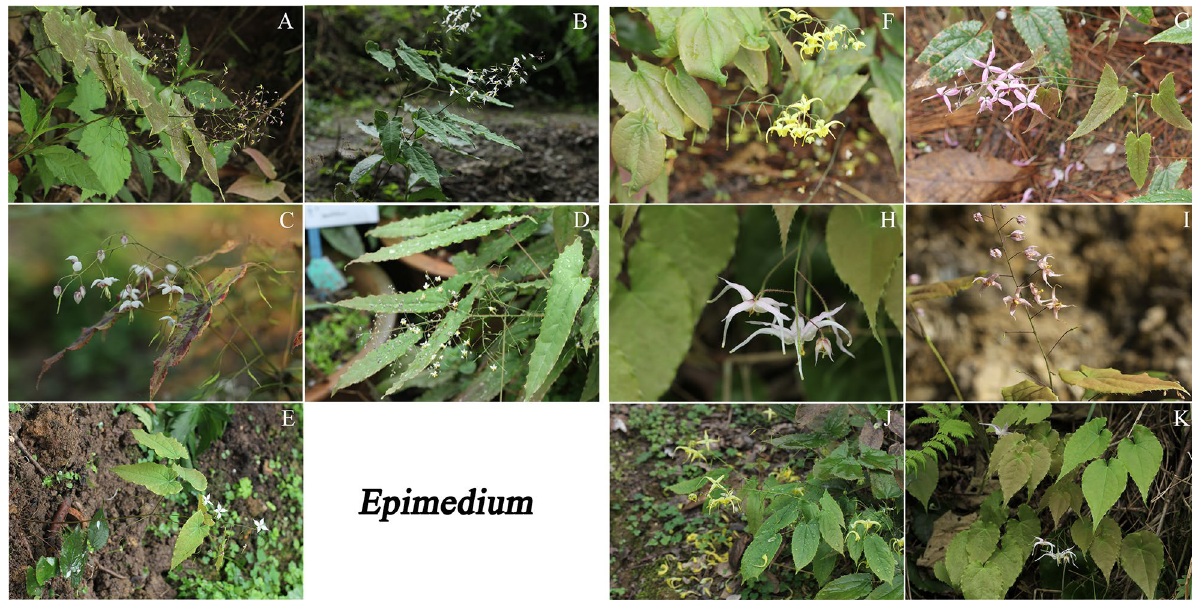
Figure 1. The Herba Epimedii cultivars, including five small ( A–E ) and six large ( F–K ) flower